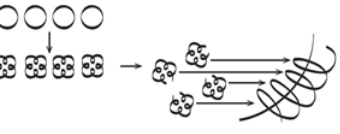
FIGURE 5. Self-organization of “particles” in the pattern of spiral